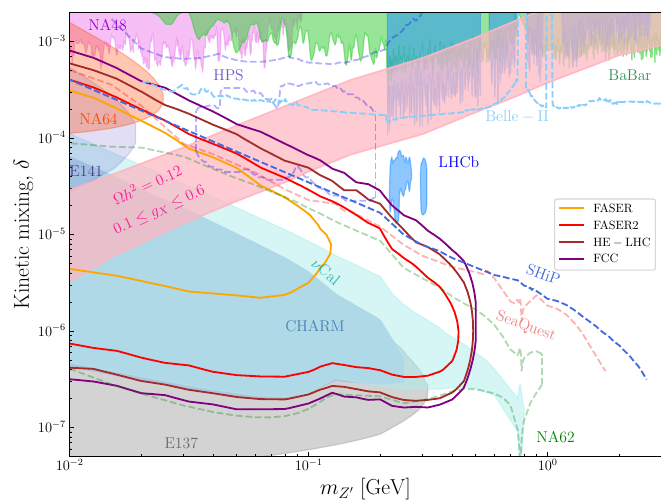
Figure 11 . The predicted sensitivity reach as determined by FORESEE for future forward detectors: FASER (orange line), FASER2 (red line), HE-LHC (brown line) and FCC (purple). Other